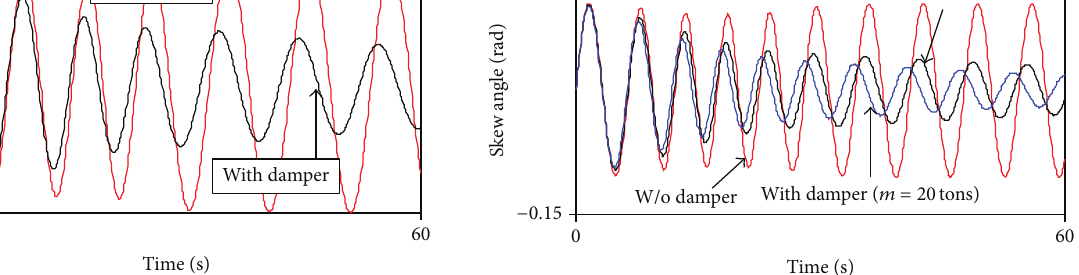
Figure 9: Effect of mass variance on the spreader skew angle.